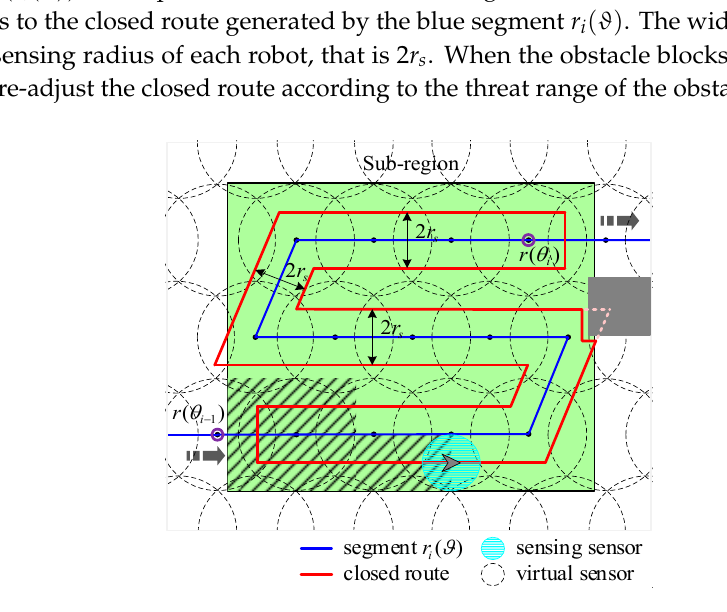
Figure 10. An example of the closed route generated by the segment. Green area indicates sub-region. Grey rectangle is obstacle. The shaded area is the field that robots have scanned. The termination point of each segment is inside the purple circle.